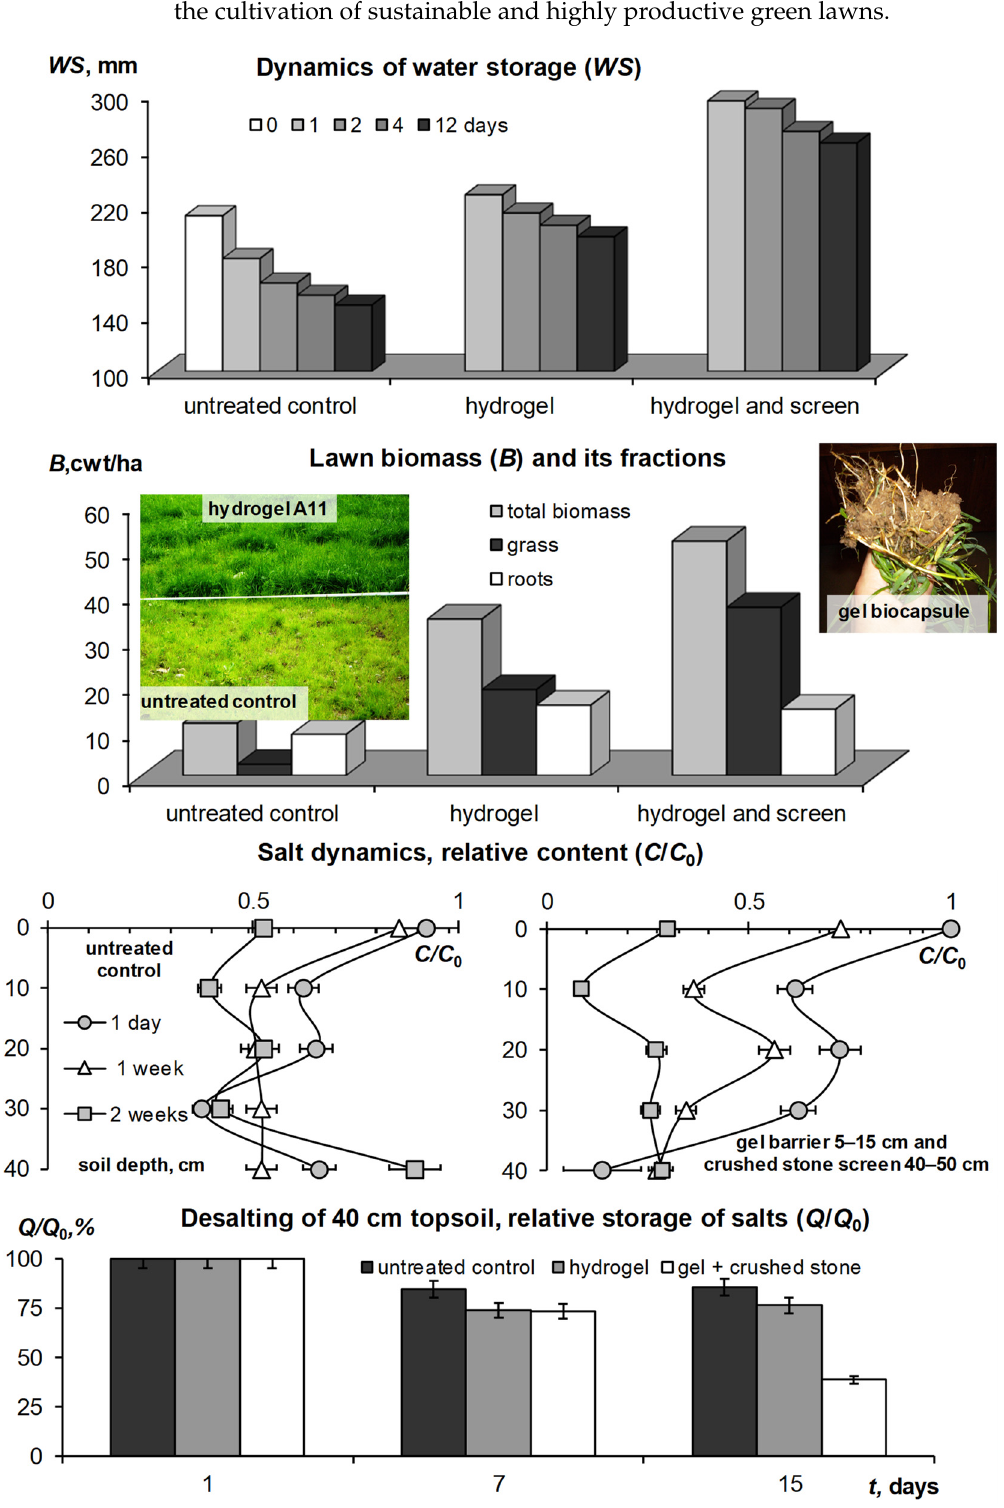
Figure 6. Dynamics of water storage, lawn biomass and topsoil desalinization under the influence of A11-gel-forming conditioner and anti-salt crushed stone screen (Moscow metropolis, 2010).